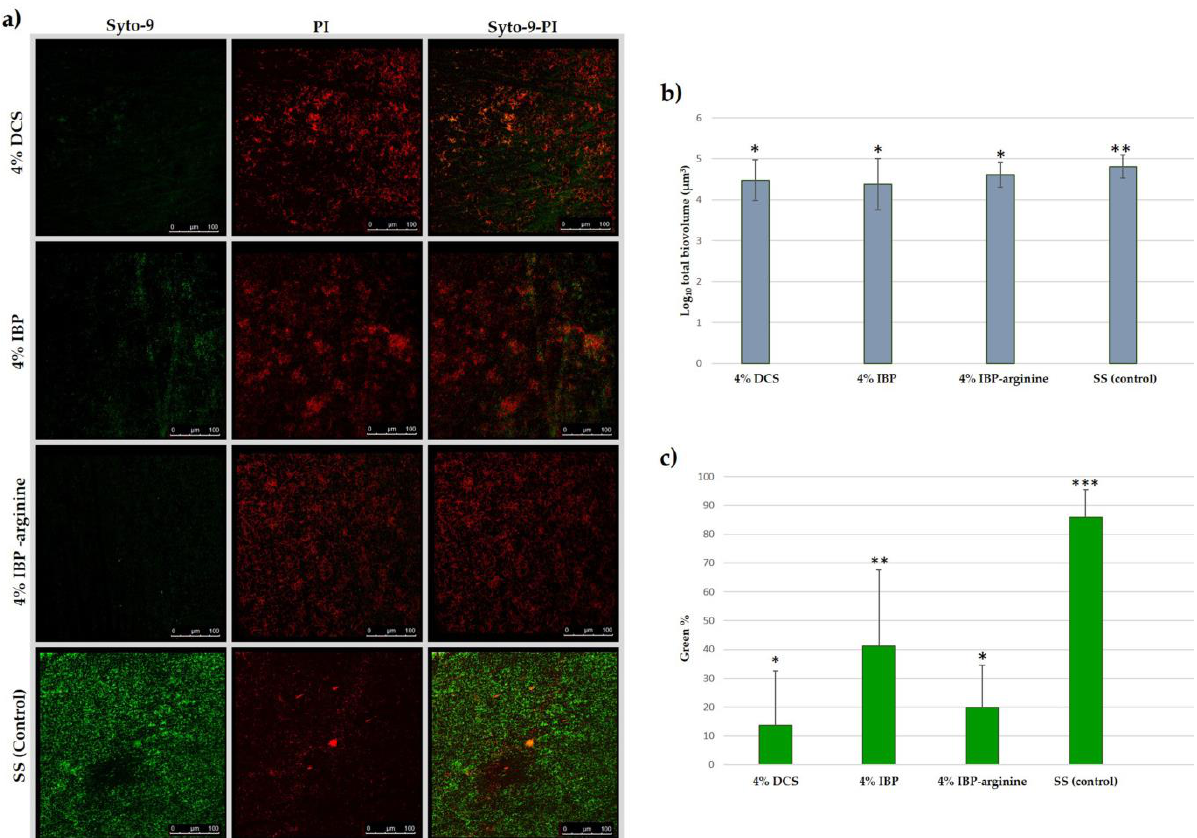
Figure 2. ( a ) Representative images of 3-week biofilms treated with diclofenac (DCS), ibuprofen (IBP), IBP-arginine and saline solution (SS) visualized under CLSM after staining with Syto-9/PI. Syto-9 stained nucleic acid and emitted green fluorescence (considered as live cells), whereas damaged cells were stained by PI (red fluorescence for dead bacteria); ( b ) the Log 10 total biovolume in the groups was similar and showed a scarce but significant reduction with respect to the control. ( c ) Mean (SD) percentage of green (live) cells by group ( n = 20 stacks/group). * The 4% DCS and 4% IBP- arginine groups gave the lowest viable cell percentages, without significant differences between them ( p < 0.001). ** The 4% IBP group showed the highest percentage of viable cells, having statistically significant differences from the other groups. *** The control group showed statistically significant differences with all the experimental groups. Table 2. Viability percentage of 3T3-L1 fibroblasts determined by optical density after contact with the solutions at two time periods and dilutions. Mean ± standard deviation (SD). n = 12/group.